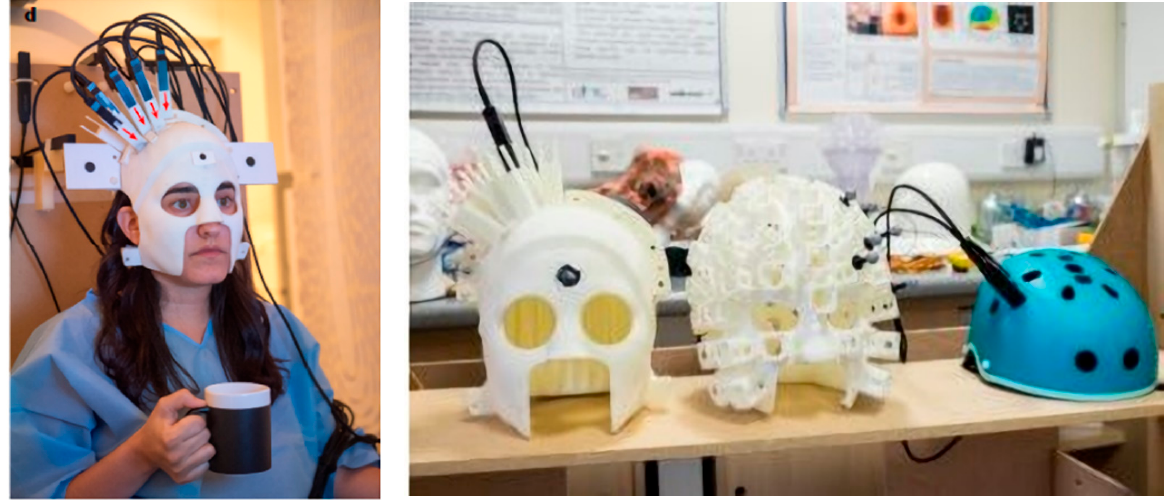
Figure 22. Magnetic brain probe array, Nottingham, UK (2018). Reprinted from Ref [108].